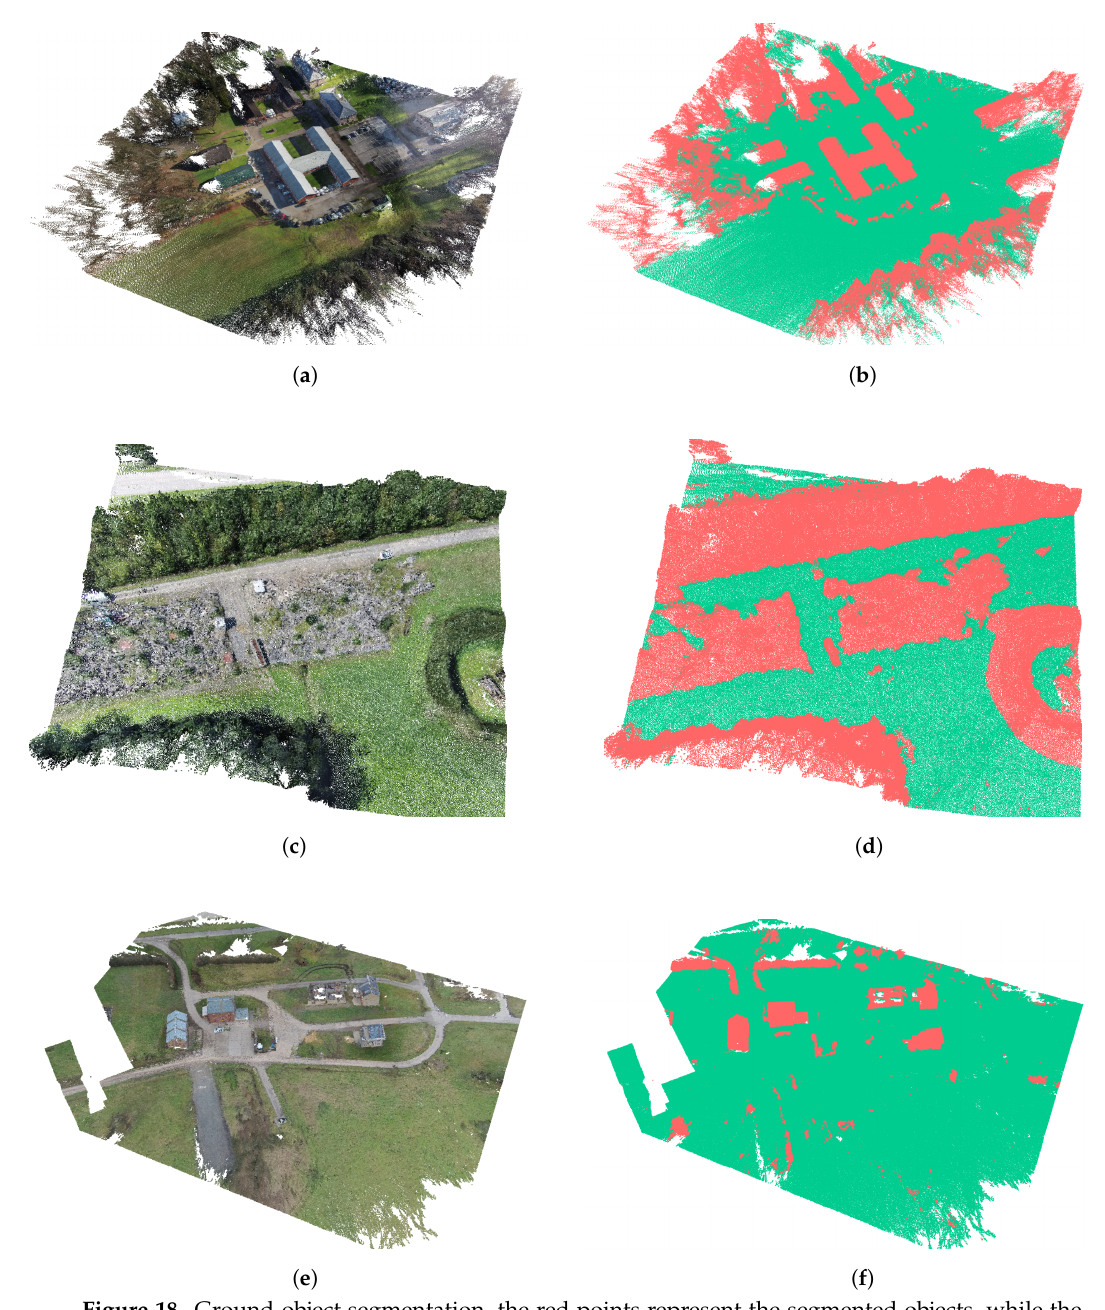
Figure 18. Ground-object segmentation, the red points represent the segmented objects, while the green points represent the ground area. The different scenarios are represented as follows: Dovo ( a , b ), Rubble ( c , d ) and Village ( e , f ). Table 6. Number of estimated object and ground points for each scenario with its percentage with the respect to the total number of points in